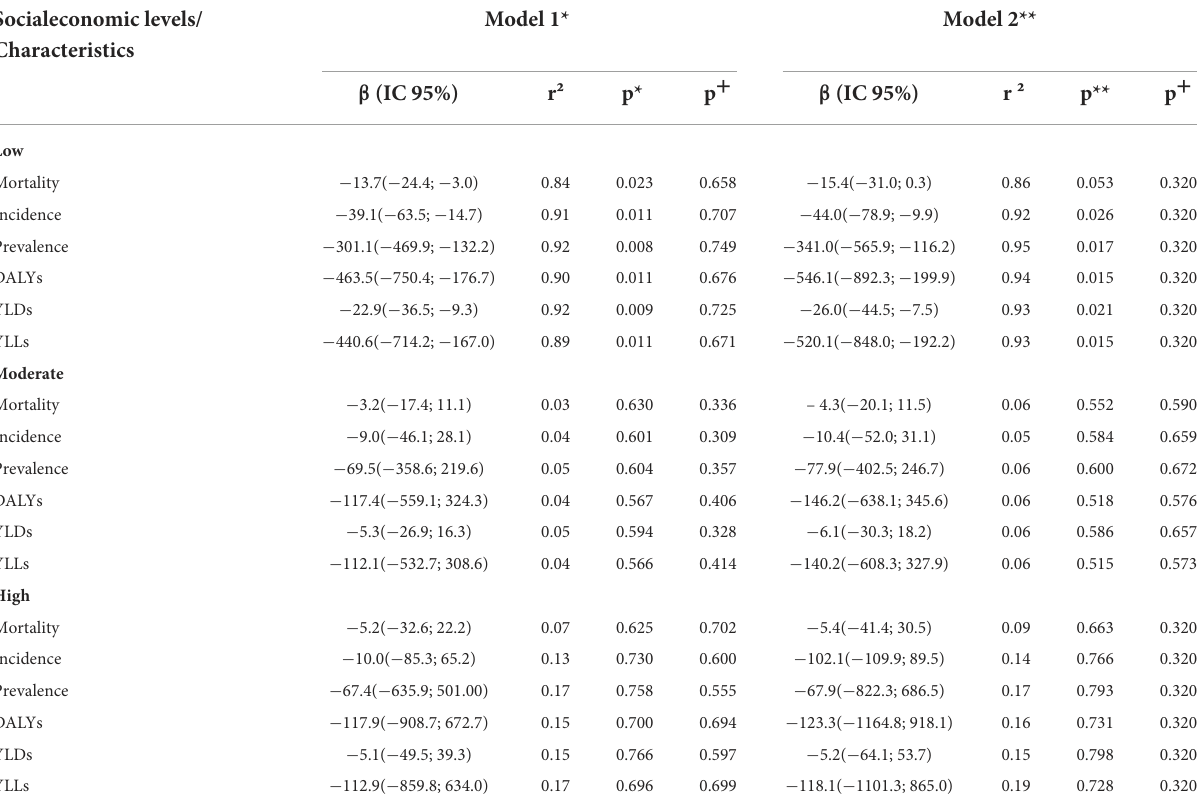
TABLE 3 Impact of income inequality on breast cancer mortality according to socioeconomic status in the federative units of Brazil in 2017. Socialeconomic levels/